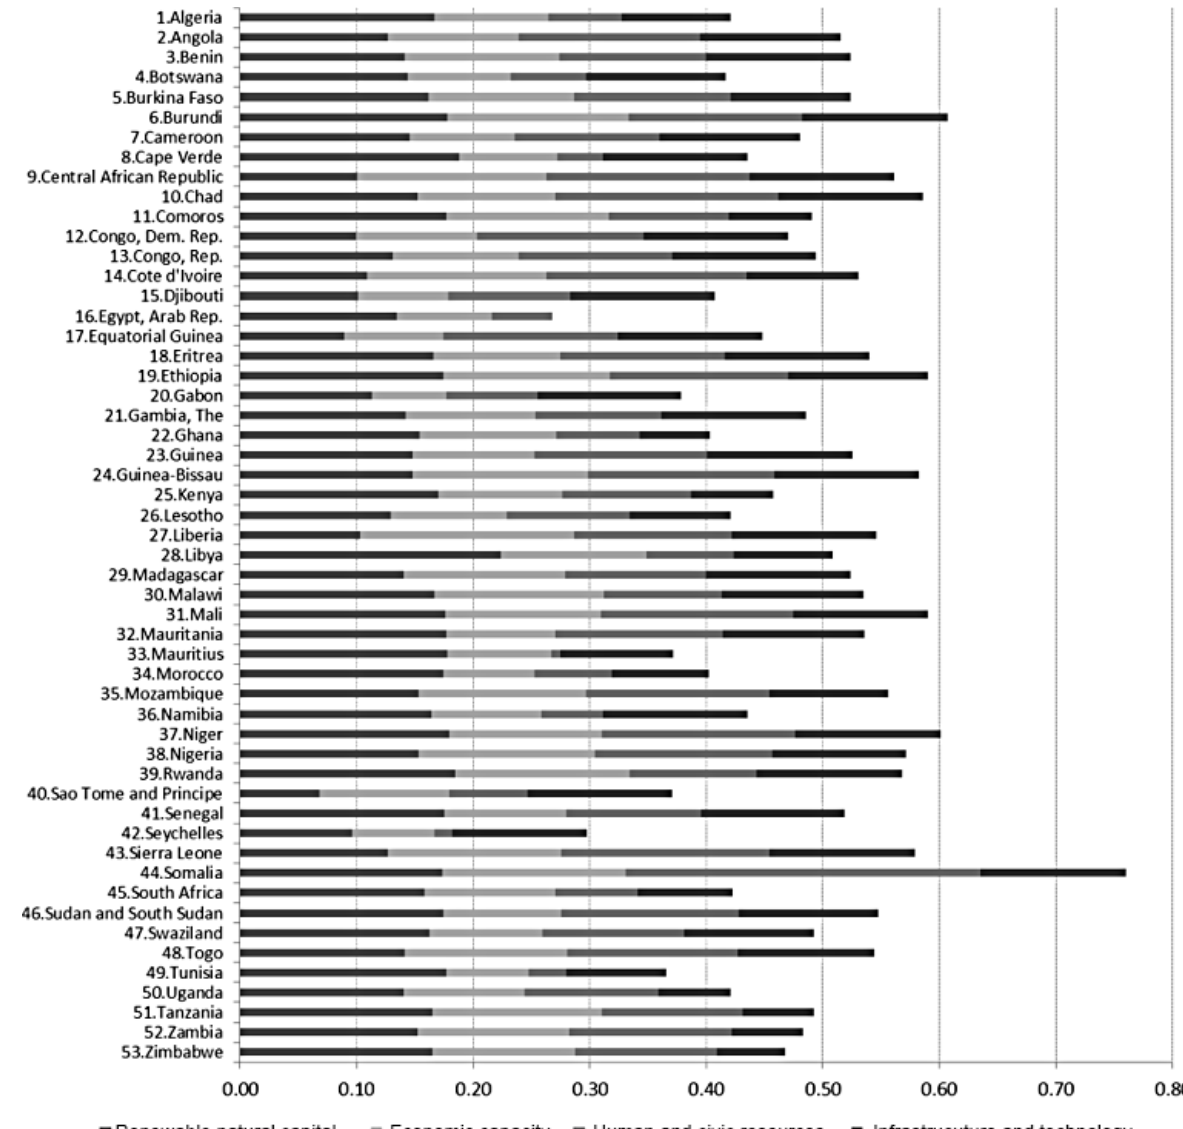
Fig. 7. Drought vulnerability index (DVI) disaggregated into their four components: renewable natural capital, economic capacity, human and civic resources, and infrastructure and technology. Countries are ordered by alphabetical